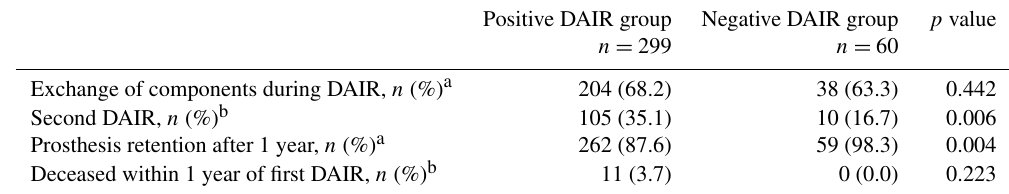
Table 2. Outcome measures of DAIR-treated patients ( n =